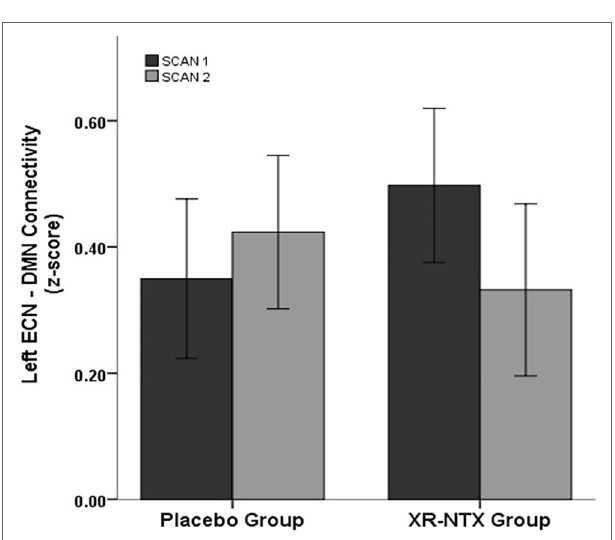
FIGURE 3 | Change in network correlations. Left ECN–DMN correlation. The XR-NTX group show significant reductions between Scan 1 and Scan 2 in Left ECN–DMN coupling compared to the placebo group (p =